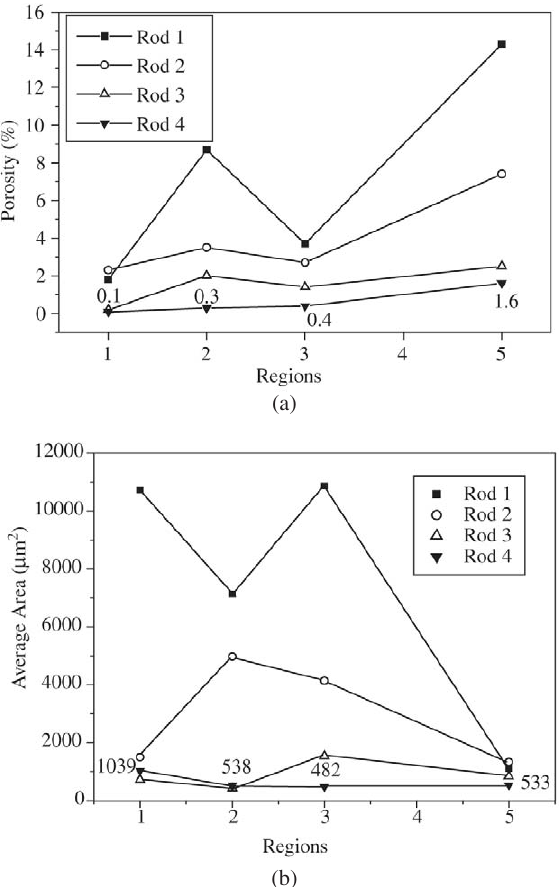
Figure 7. Porosity distribution: a) pore concentration; b) pores average size. The alloy was microstructurally conditioned by TMT. See text for description of the process variables employed for rods 1 to